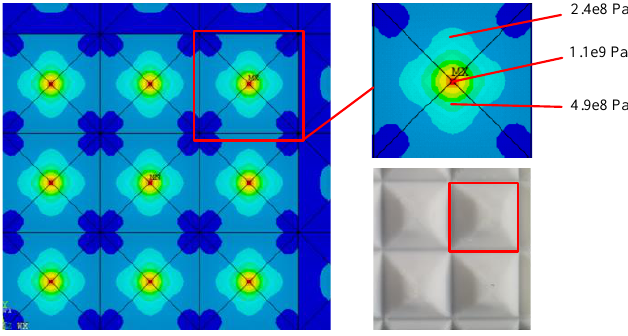
Figure 15. The compressive deformation of the OL-4-3/4 panel compared with the tested sample.